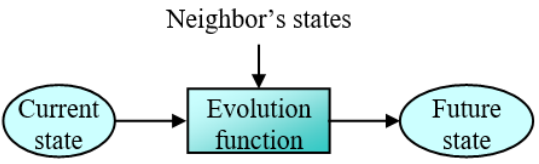
Figure 1. Structure of cellular automata.